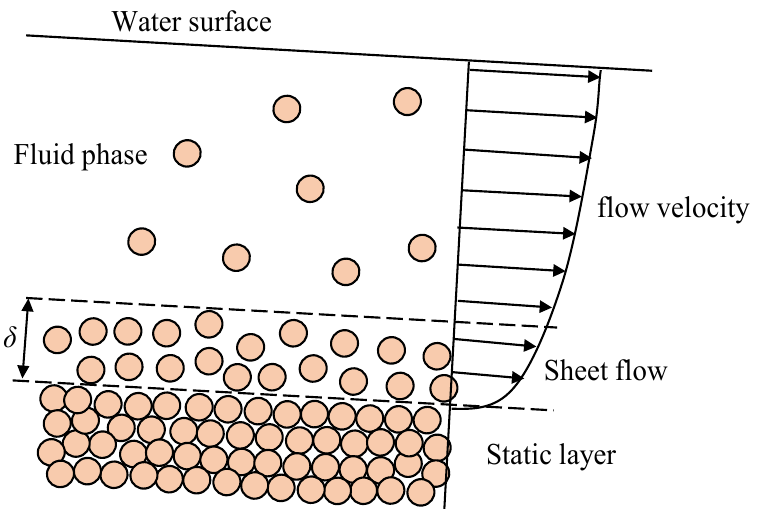
Figure 4. A schematic diagram of sheet flow with a thickness of δ (reproduced following [101]).